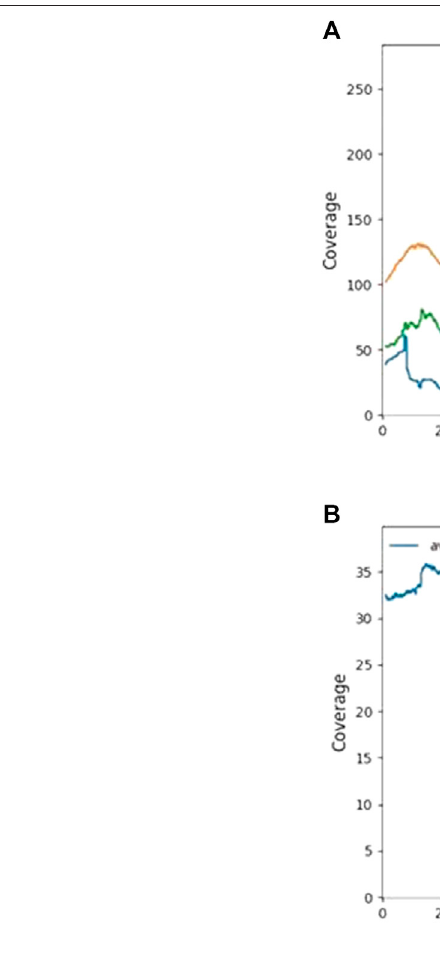
FIGURE 3 | Nucleotide by nucleotide coverage of DNAAF3 in ES and GS. The line plot shows the average coverage of each nucleotide in the DNAAF3 gene. (A) CoverageofESsplitacrosslibrarypreparationkits.Across30 ESsamplesthatusedTruseq,anaverageof0×readdepthwasseenforexon5of DNAAF3 . (B) Coverage of GS across the DNAAF3